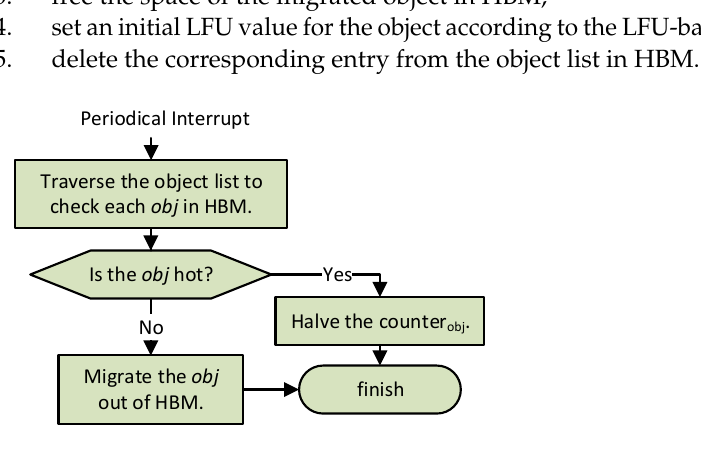
Figure 4. The migration workflow of HBM Migr-out from HBM to